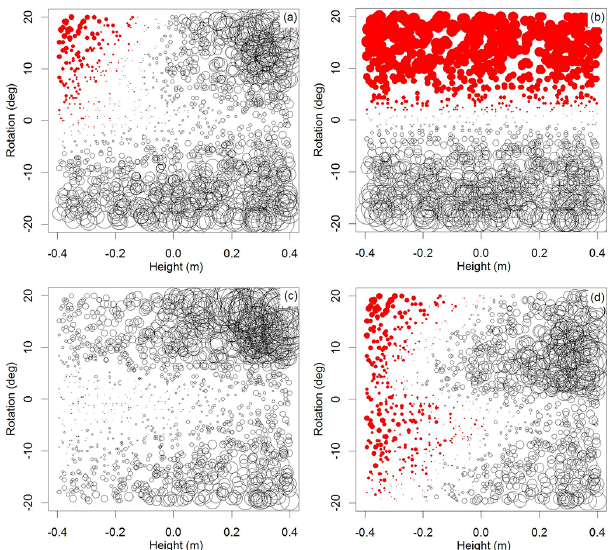
Figure 6. Plots of perturbation in wave direction and significant wave height for each member of the ensemble for (a) the entire coast, (b) the northern section (1), (c) the central section (2), (d) and the southern section (3). The size of each symbol is proportional to the change in mean relative erosion rate imparted by that wave climate in comparison to the baseline scenario. Red dots represent increased erosion relative to the baseline and empty circles reduced